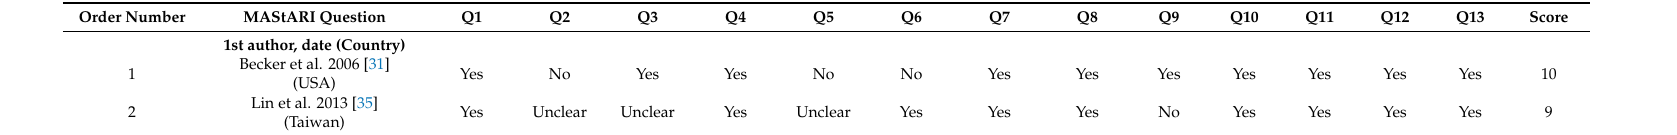
Table 5. Results of critical appraisal for Randomized Controlled